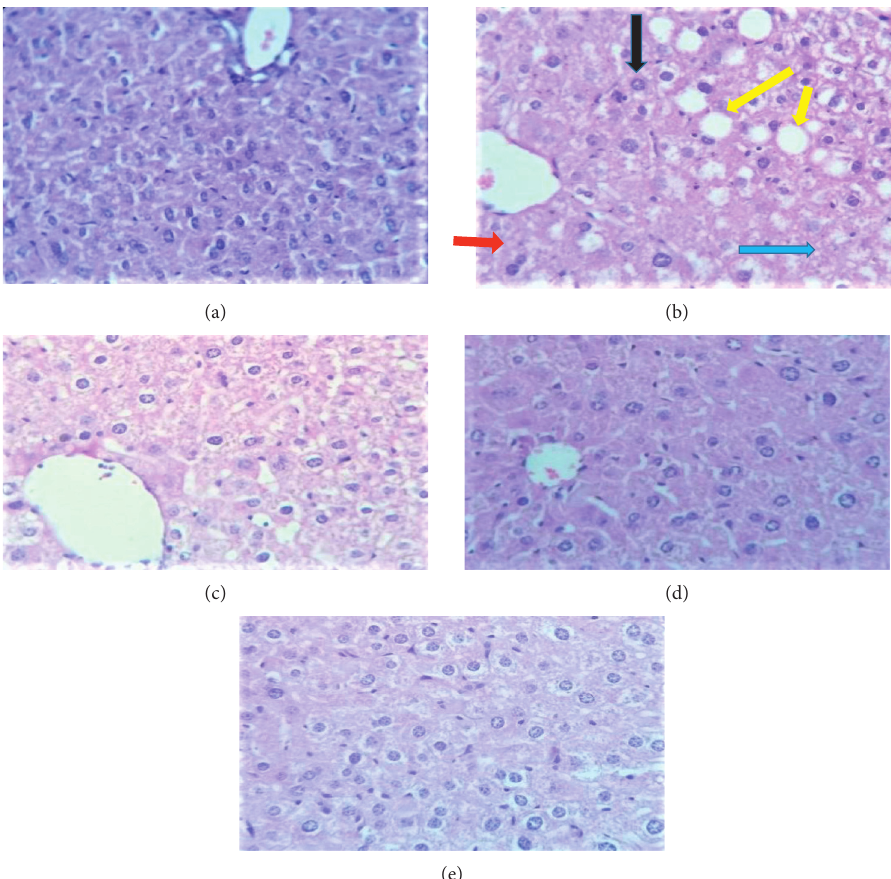
Figure 2: Photomicrograph of the liver of experimental animals (stained with hematoxylin and eosin). Group I (a); group II (b); group III (c), group IV (d), and group V (e). Red arrow, hypertrophy; black arrow, vacuolar change; yellow arrow, fatty change, and blue arrow inflammatory